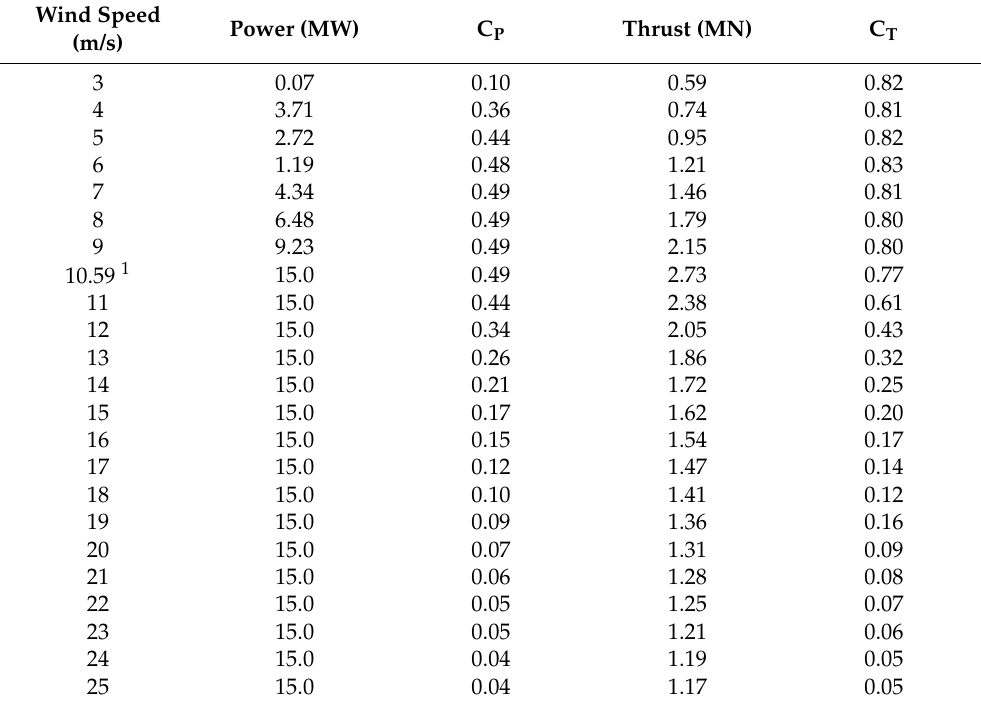
Table 15. Turbine quasi-static characteristics. Wind